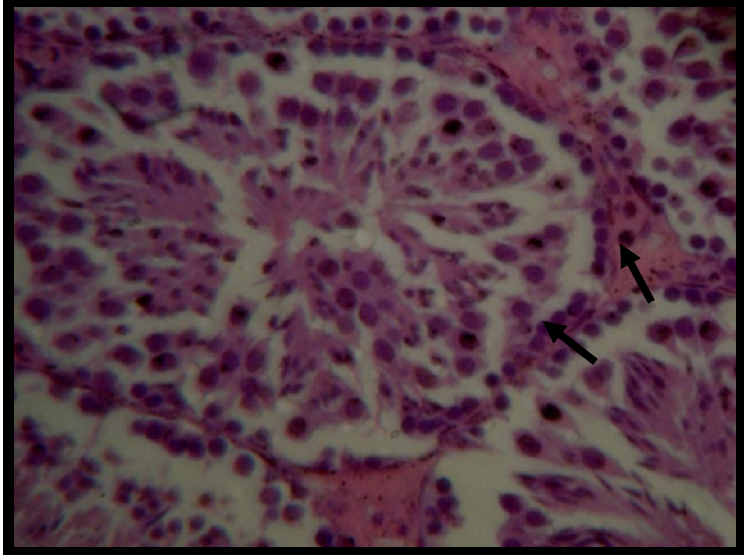
Fig. 3: Histopathological section of testis of the male Mice after 30 days post treatment with smut wheat show thickness of basement membrane of semineferous tubule due to fibroses ( ) ,(H & E stain 40X).